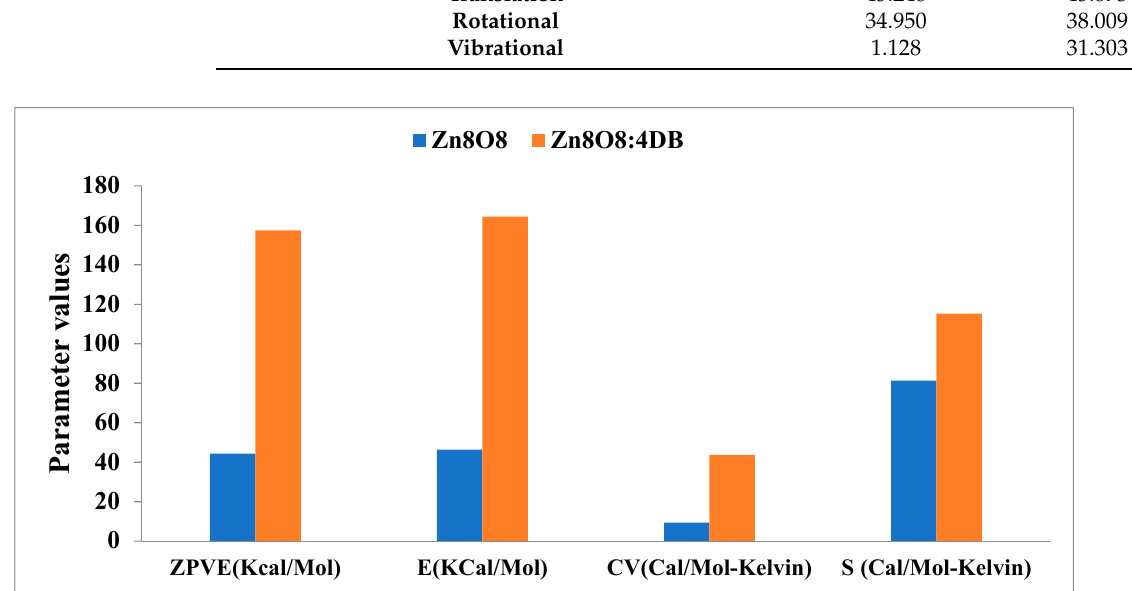
Figure 9. Thermodynamic zero-point vibrational energies (ZPVE), thermal energy (E), molar capacity at constant volume (C V ), and entropy (S) of the total energy for the Zn8O8 and Zn8O8:4DB clusters.